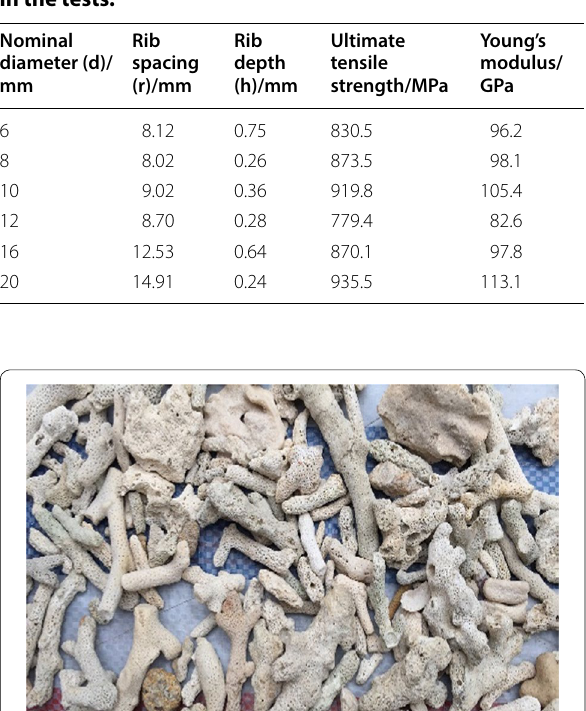
Table 1 Mechanical properties of BFRP rebars used